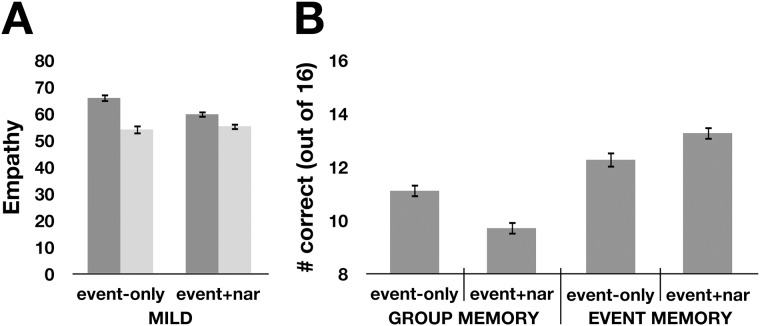
Narrative descriptions impair memory for group membership while improving memory for target-specific events.(A) Empathic responses to in-group targets (dark bars) and out-group targets (light bars) in response to mild fortunes/misfortunes presented by themselves (event-only) or after a narrative about the target (event+narrative). (B) At the end of the study, participants performed a 2-alternative forced-choice task to recall the group membership of each of the 16 targets (group memory), or the event that happened to each target (event memory). Error bars show standard error of the mean.